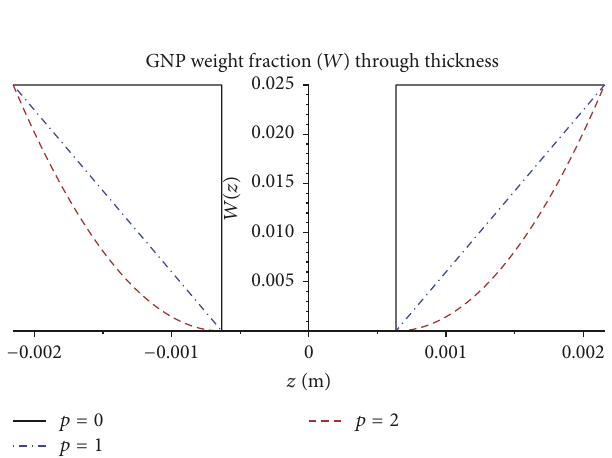
Figure 5: Graphene nanoplatelets weight fraction distribution through skins’